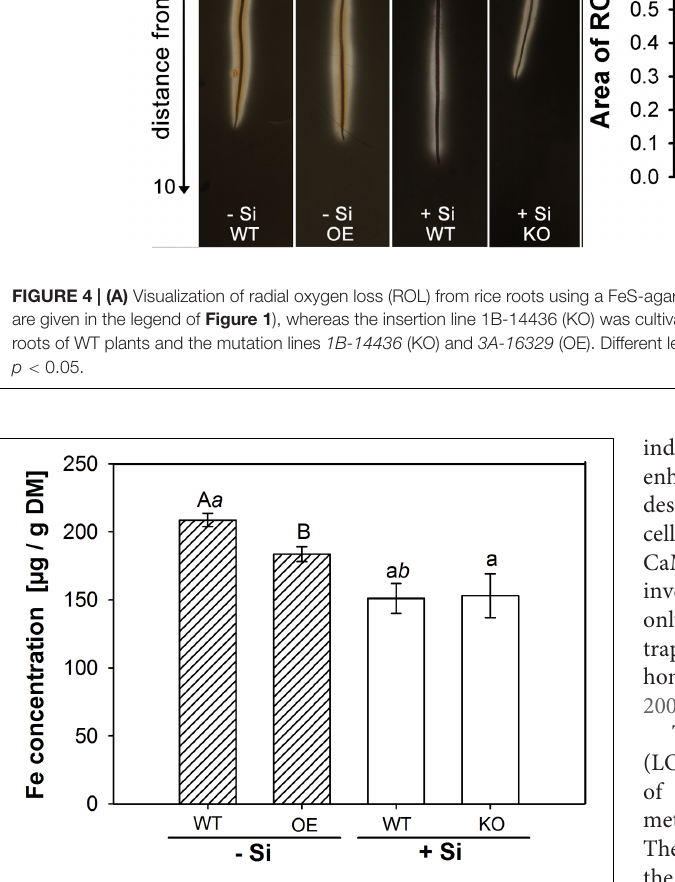
FIGURE 5 | Iron content in shoot dry matter. The WT plants were grown with low (–Si) and high (+Si) Si supply (conc. are given in the legend of Figure 1 ), whereas the insertion line 1B-14436 (KO) was cultivated only in +Si and mutant 3A-16329 (OE) only in –Si. Different capital, small and italic letters indicate a significant difference between treatments; students t -test with p <